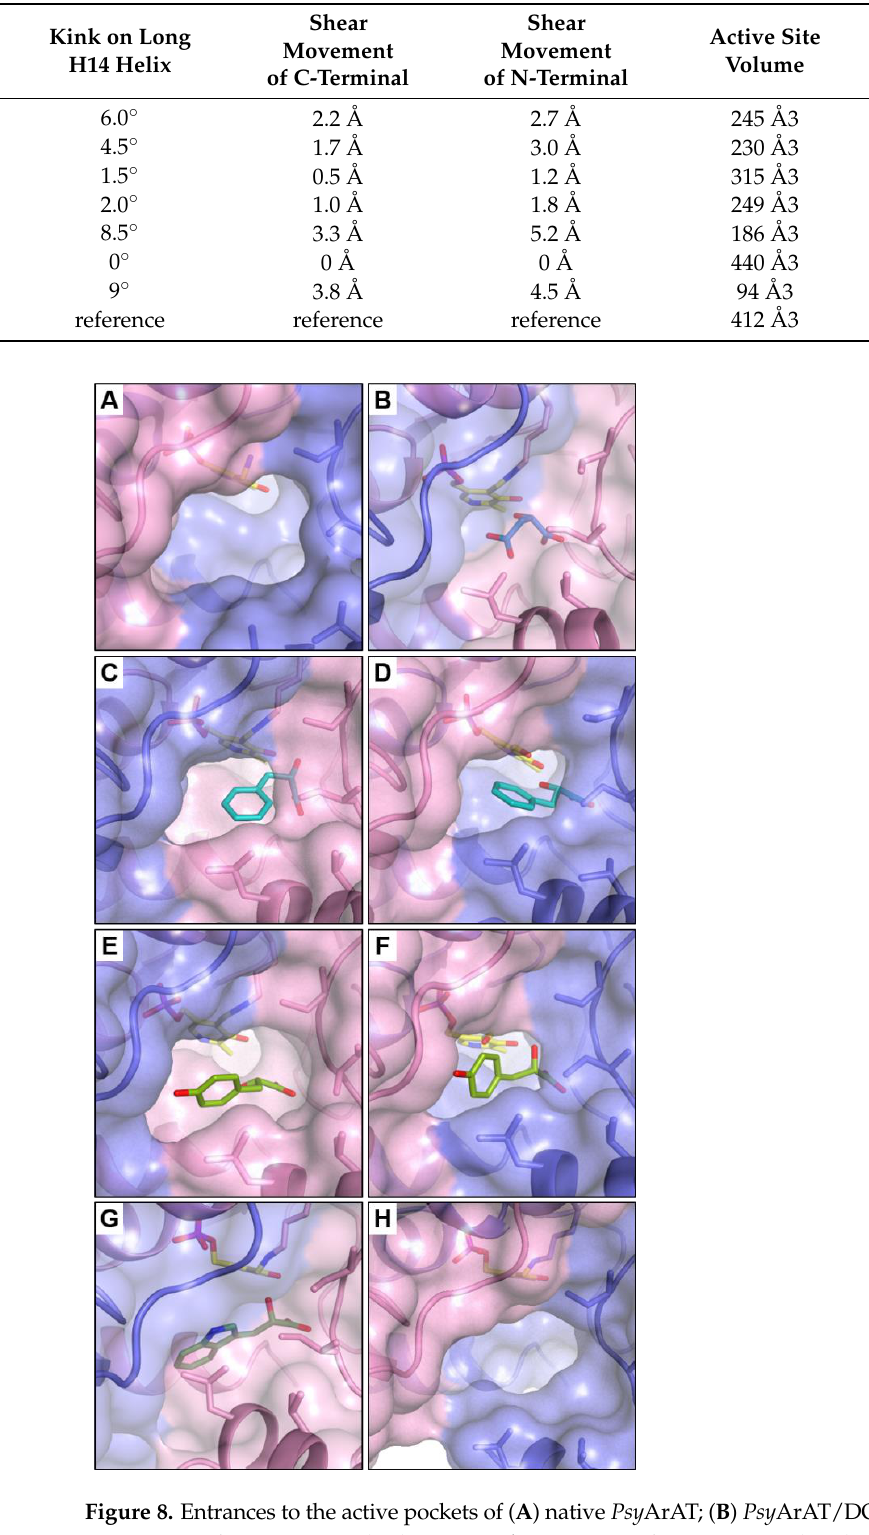
Table 2. Parameters showing conformational changes in PsyArAT complexes (for the calculation of the active site volume and area, 1.2 diameter of the probe was used).